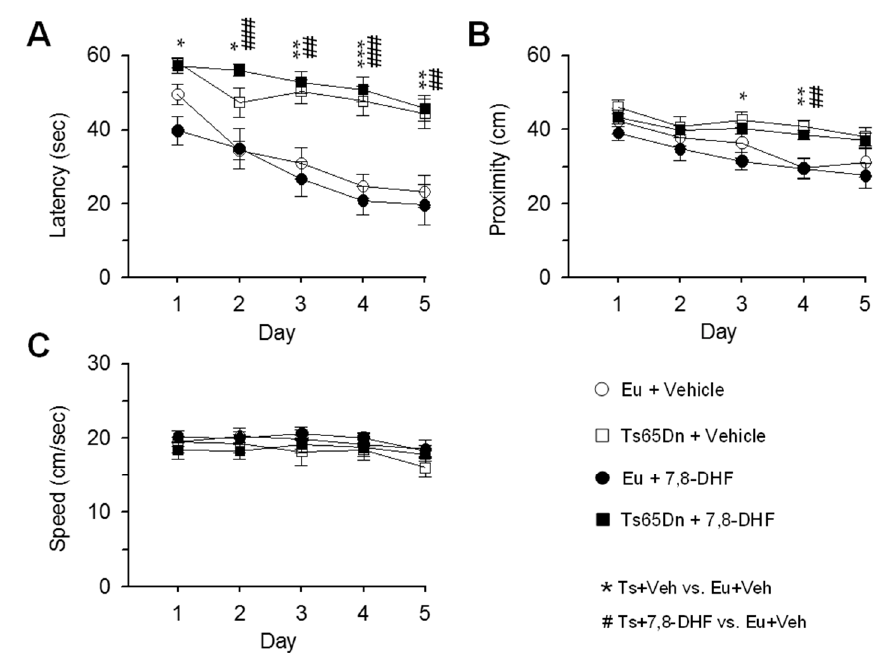
Figure 2. E ff ect of neonatal treatment with 7,8-DHF on spatial learning in Ts65Dn and euploid mice. Mice were injected with either vehicle or 7,8-DHF in the period P3–P15 and their behavior was tested with the MWM beginning from the age of 35–42 days (untreated euploid mice: n = 11; untreated Ts65Dn mice: n = 10; treated euploid mice: n = 11; treated Ts65Dn mice: n = 9). The data in ( A – C ) refer to euploid mice that received either vehicle (empty circle) or 7,8-DHF (filled circle) and Ts65Dn mice that received either vehicle (empty square) or 7,8-DHF (filled square). A,B: In the learning phase of the MWM, the latency to reach the platform ( A ), proximity to the platform zone ( B ), and swimming speed ( C ) were evaluated. Values are mean ± standard error (SE). The symbol * indicates a di ff erence between untreated euploid and untreated Ts65Dn mice and the symbol # indicated a di ff erence between untreated euploid mice and treated Ts65Dn. One symbol: p ≤ 0.05; two symbols: p ≤ 0.01; three symbols: p ≤ 0.001 (Fisher LSD test after ANOVA). Abbreviations: 7,8-DHF, 7,8-dihydroxyflavone; cm, centimeters; Eu, euploid; sec, seconds; Ts, Ts65Dn; Veh, vehicle.